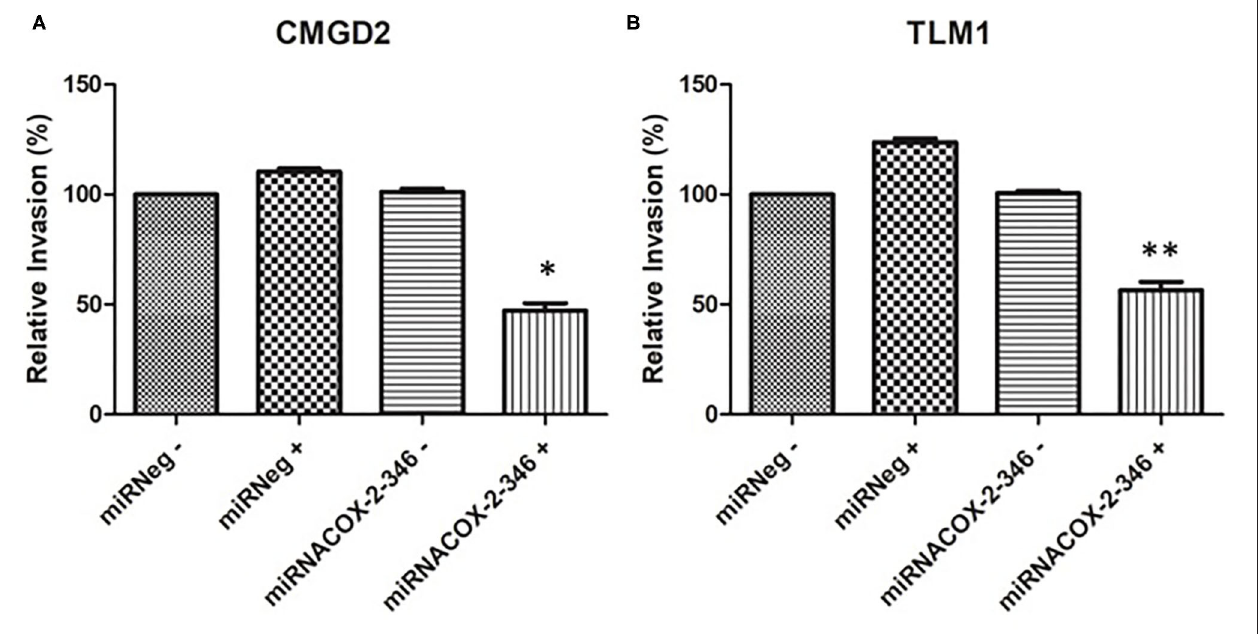
FIGURE 4 | COX-2 regulates cell invasion. (A) CMGD2 and (B) TLM1 cells were transfected with either miRNACOX2-346 or the miRneg negative control with ( + ) or without (–) DOX. Invasion potential was determined 48h after seeding into a transwell chamber assay (QCM TM collagen-based cell invasion assay kit) ( p = 0.0004*, p =